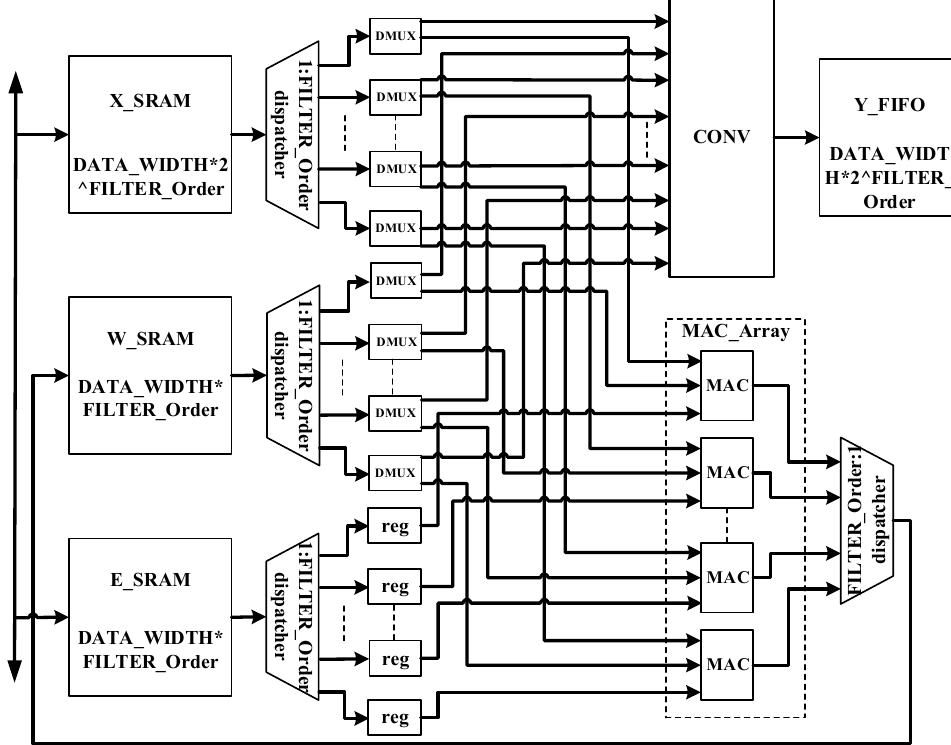
Figure 4. Structure diagram of hardware accelerator.